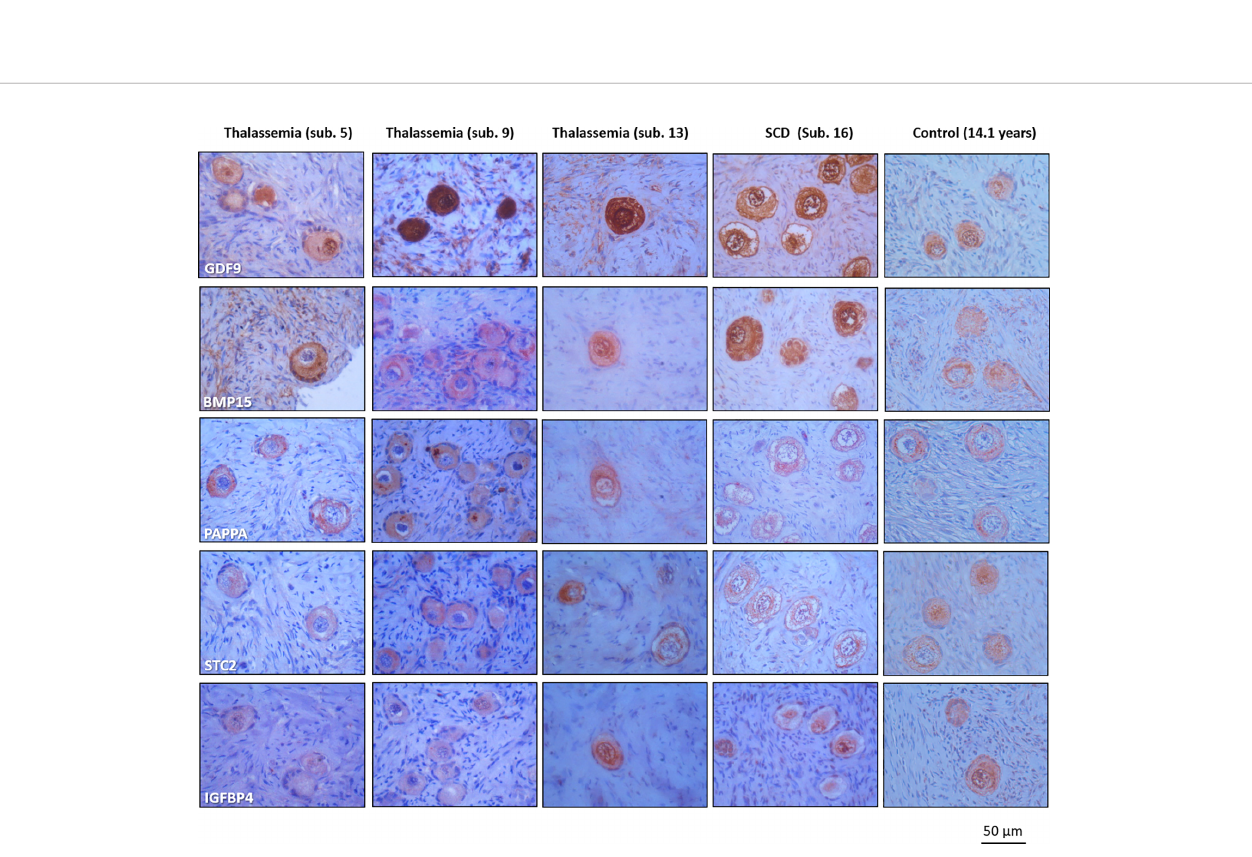
FIGURE 3 | Similar detection of growth differentiation factor 9 (GDF9). Bone morphogenetic protein 15 (BMP15), pregnancy-associated plasma protein A (PAPPA), stanniocalcin 2 (STC2), and insulin-like growth factor-binding protein 4 (IGFBP4) in ovarian cortex with thalassemia and sickle cell disease and in one age-matched reference biopsy.